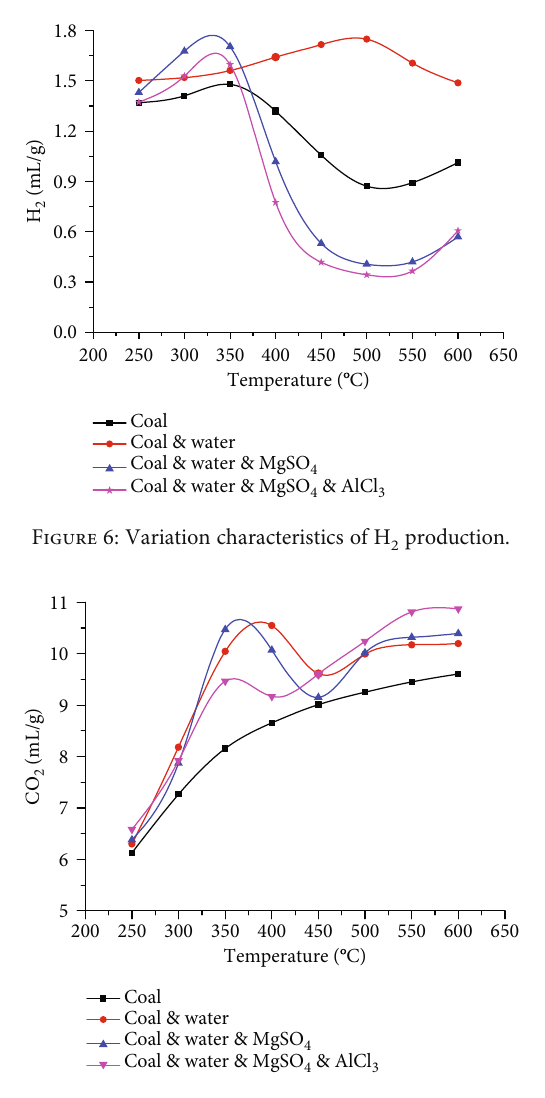
Figure 7: Variation characteristics of CO